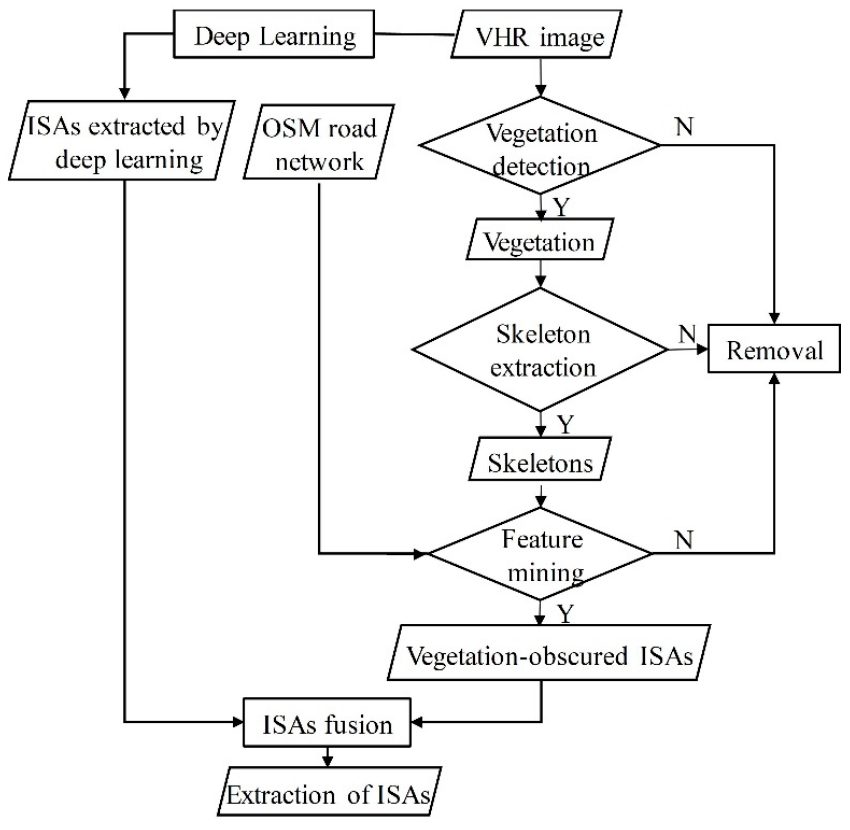
Figure 2. The flowchart of the extraction of ISAs.